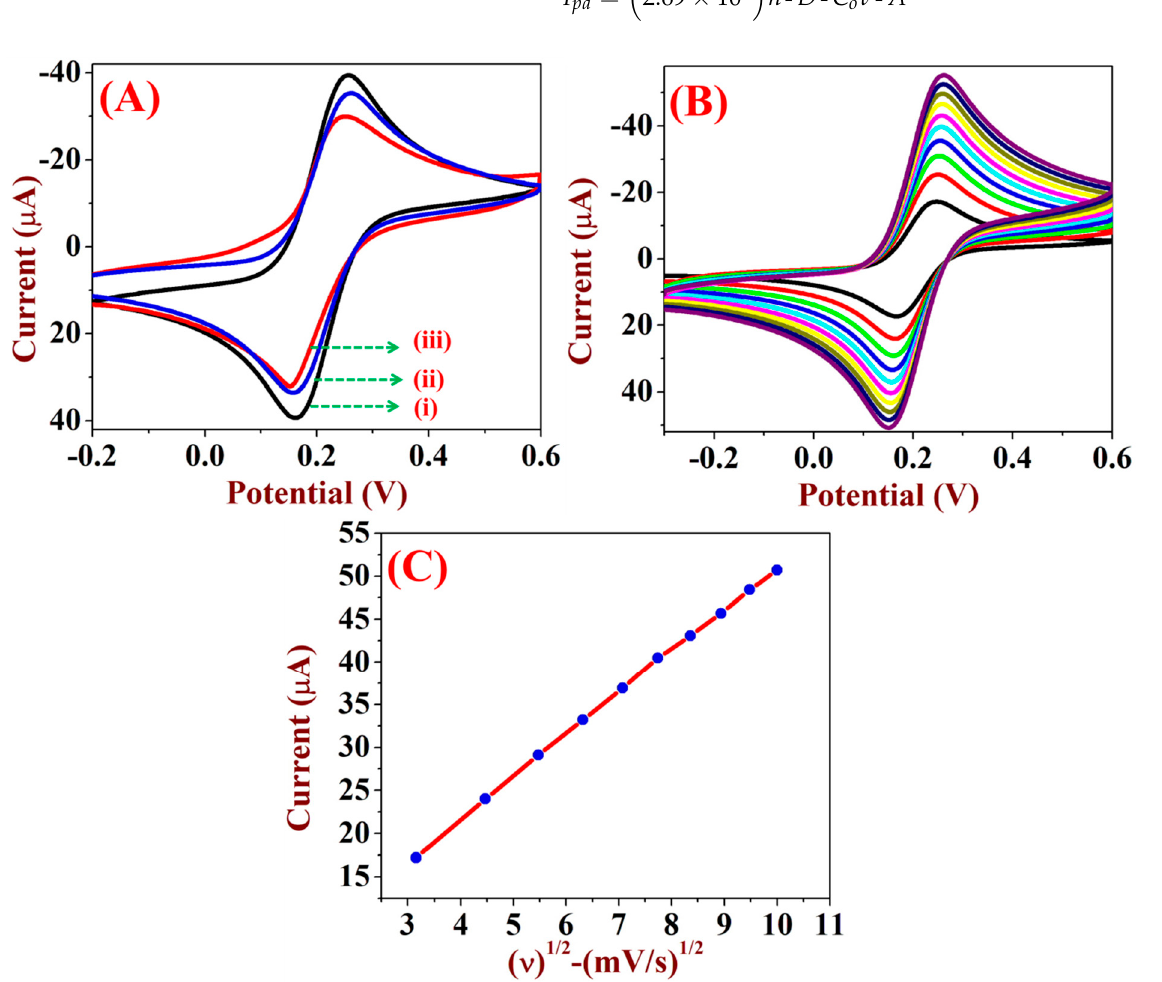
Figure 5. ( A ) CVs were recorded using unmodified electrode (curve i), FAD/Ti 3 C 2 T x /GCE (curve ii) and Ti 3 C 2 T x /GCE (curve iii) in 0.1 M KCl/5 mM [Fe(CN) 6 ] 3 − /4 − at the scan rate of 50 mV/s. ( B ) CVs for FAD/Ti 3 C 2 T x /GCE at different scan rates from 10 to 100 mV/s. ( C ) The linear plot was made between the ν 1/2 and the reduction peak currents.